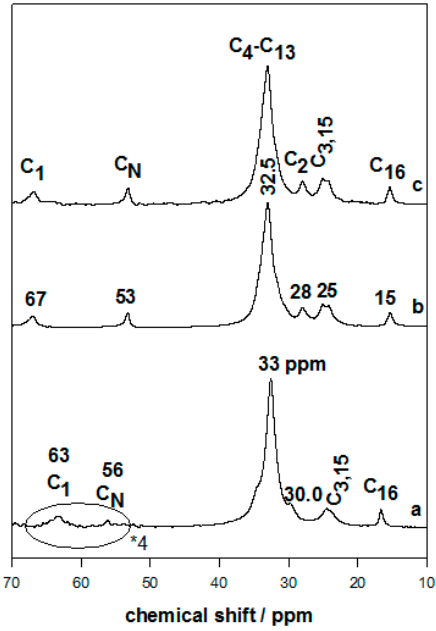
Figure 5. 13 C CP-NMR of ( a ) pure C16TMABr salt, and organo-magadiites exchanged with C16TMABr solution at different concentrations: ( b ) 0.40 mM and ( c ) 0.80 mM.